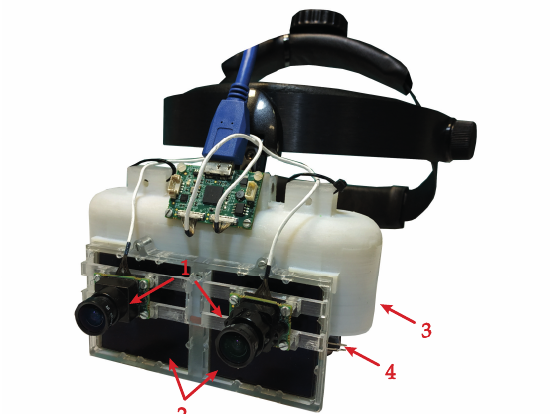
Figure 4. The custom-made hybrid video-optical see-through head mounted display used in the experimental session. 1 → Pair of stereo cameras for the inside-out tracking. 2 → Pair of liquid-crystal optical shutters to drive the switching mechanism between occluded to optical see-through state. 3 → Plastic shell that incorporates all the components of the optical see-through visor. 4 → Optical combiner of the optical see-through visor.